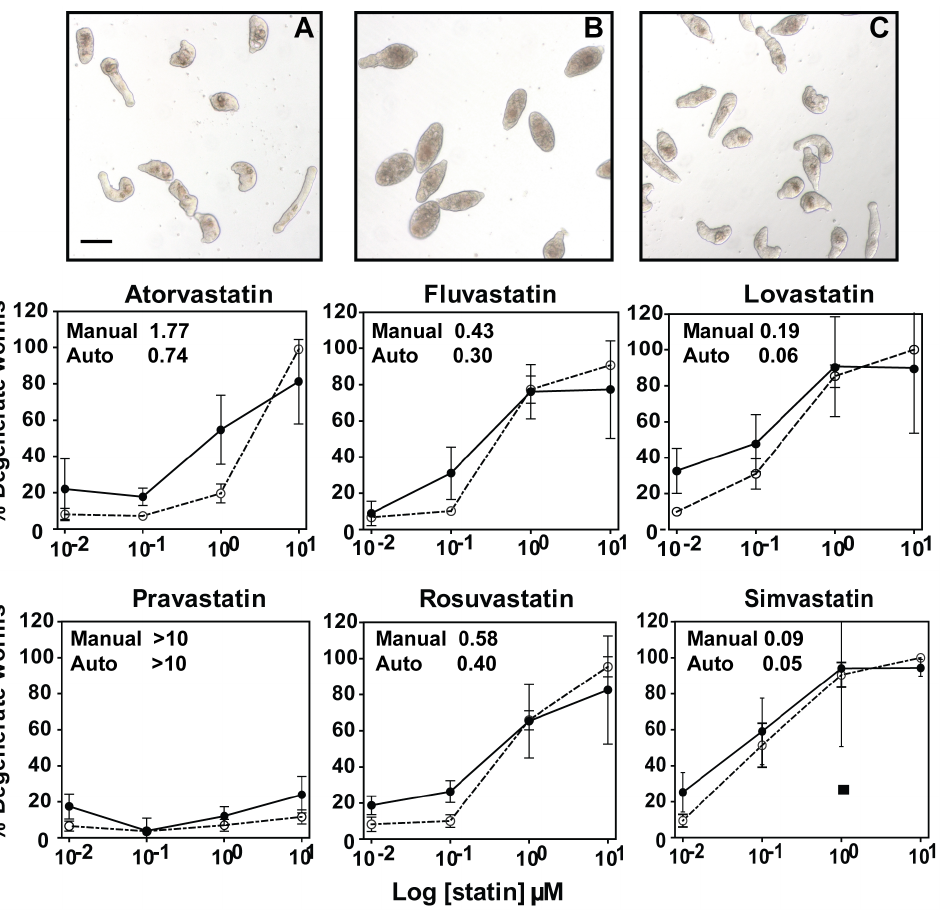
Figure 1. Concentration-dependent killing of S.mansoni somules by six commercial statins as measured manually and using a machine learning-based automated algorithm. Newly transformed somules were incubated out to four days in the presence of the concentrations of statins indicated. The percentage of degenerate worms was measured both manually (dashed curves) and using a new automated algorithm (solid curves) as described in the text. Points represent means 6 S.D. across two independent experiments each in duplicate. ED 50 values are inserted above the curves. Mevalonate (100 m M) prevented worm-kill by 1 m M simvastatin and is indicated by the single square point. Image panels display somules cultured for four days; (A) DMSO control, (B) 1 m M simvastatin (indicating the rounded and darkened (degenerate) response)